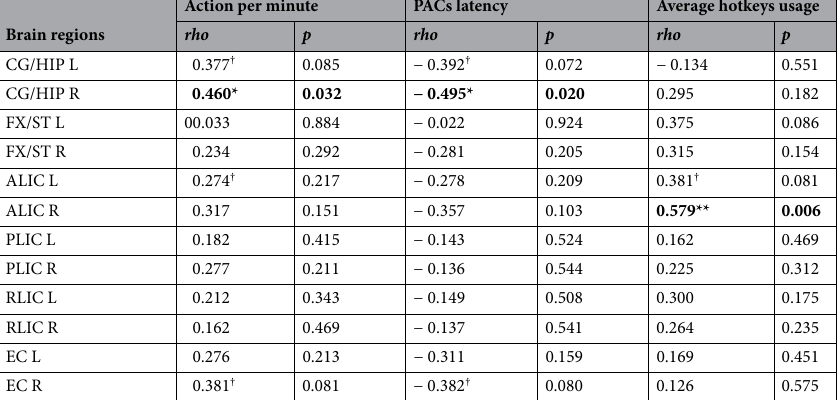
Table 1. Results of correlations between FA in the WM regions and StarCraft II performance indicators. The results presented in the table are without the FDR correction. L left, R right, CG/HIP cingulum/hippocampus, FX/ST fornix/stria terminalis, ALIC anterior limb of internal capsule, PLIC posterior limb of internal capsule, RLIC retrolenticular limb of internal capsule, EC external capsule, PACs perception action cycles. ** p < 0.01; * p < 0.05; † p < 0.10. Significant results are in bold.